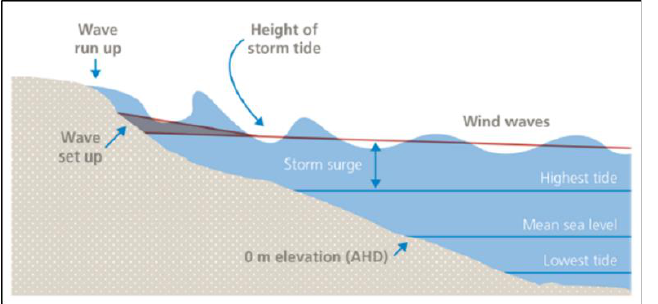
Figure 1. Schematic of tidal water level, storm surge, wave set-up and wave run-up (from [31]).